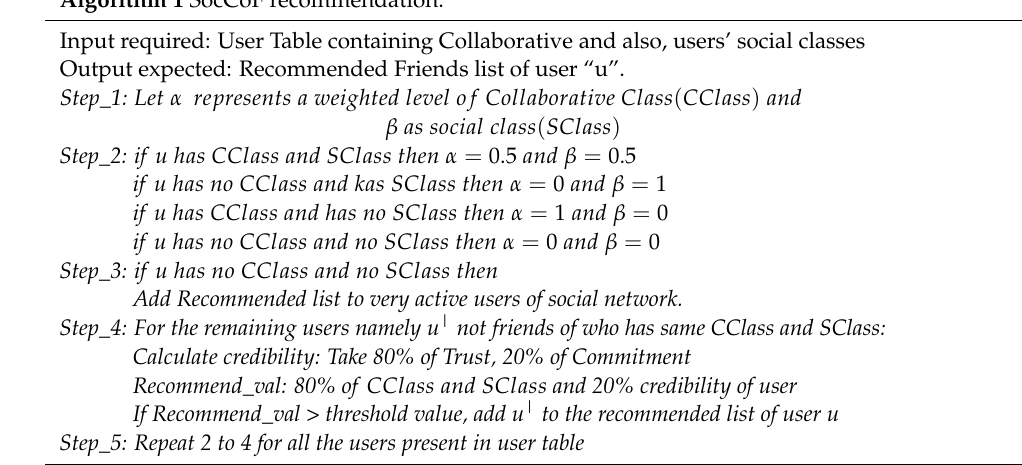
Algorithm 1 SocCoF recommendation.